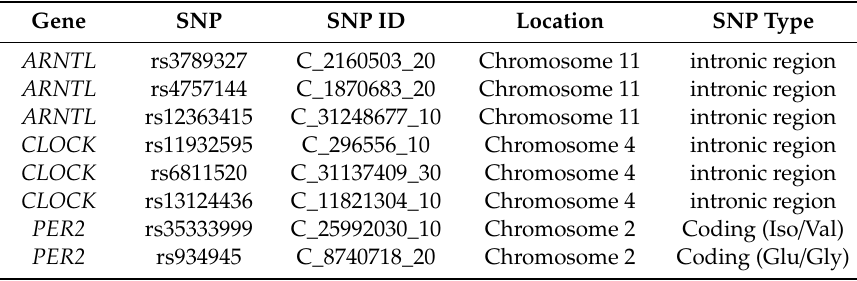
Table 1. Selected TaqMan probe details.